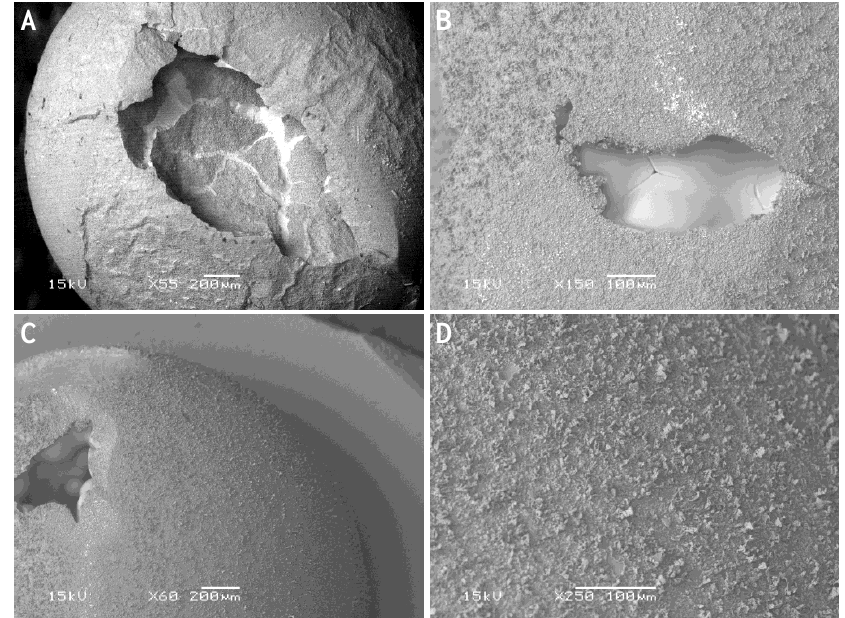
Figure 8. SEM images the outer surface of an aluminum specimen after oxidation in air at 1050 ◦ C for 12 h. ( A , C ) show the spheroidal nature of the specimens after thermal analysis. ( B ) indicates the presence of grain boundaries in the underlying Al-rich zone. ( D ) shows detail of the surface of a spheroidal